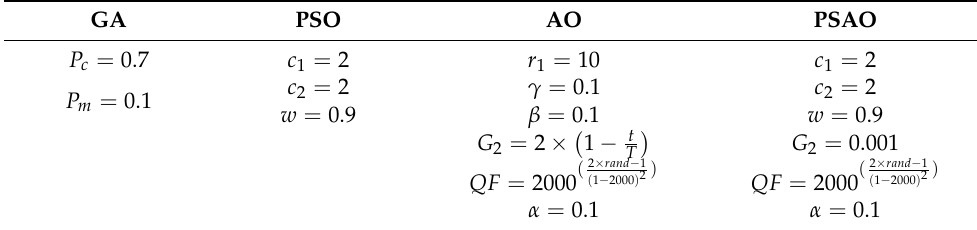
Table 3. Parameters of algorithms.